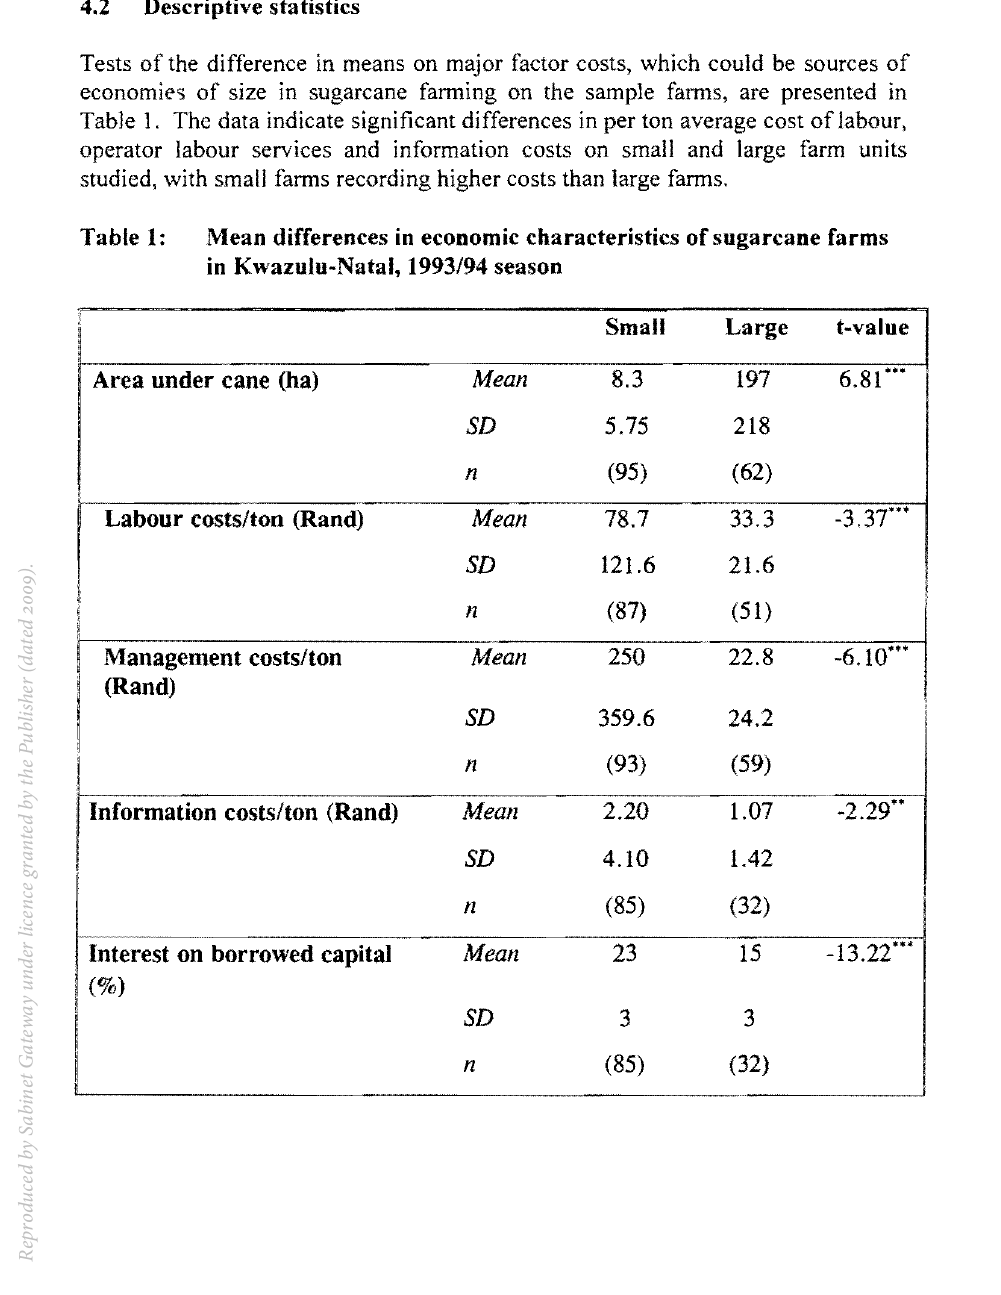
Mean differences in economic characteristics of sugarcane farms in Kwazulu-Natal, 1993/94